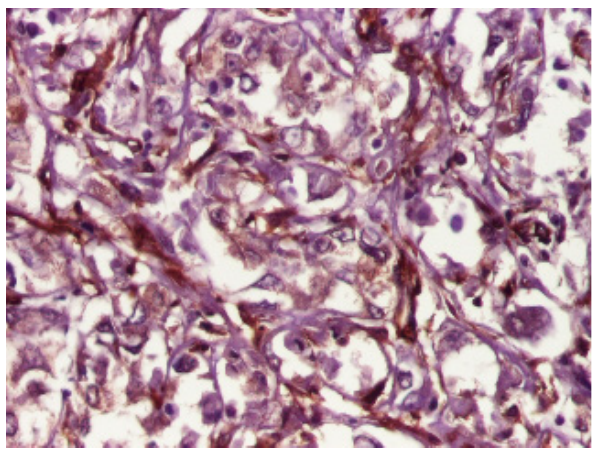
Figure 9. SMA was not expressed by the tumor cells, ×200.